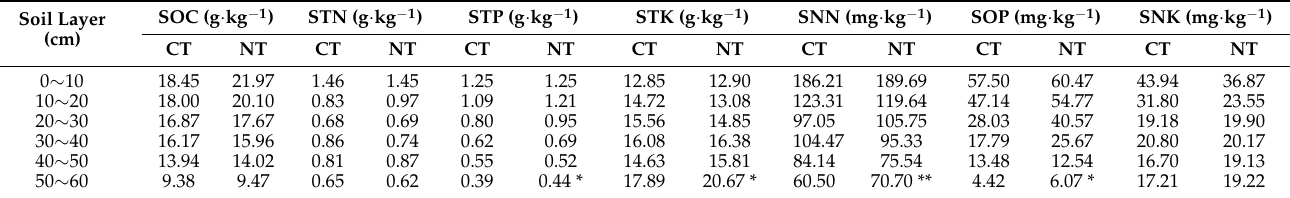
Table 2. Variation of 0–60 cm soil layer soil chemical properties in 2016.